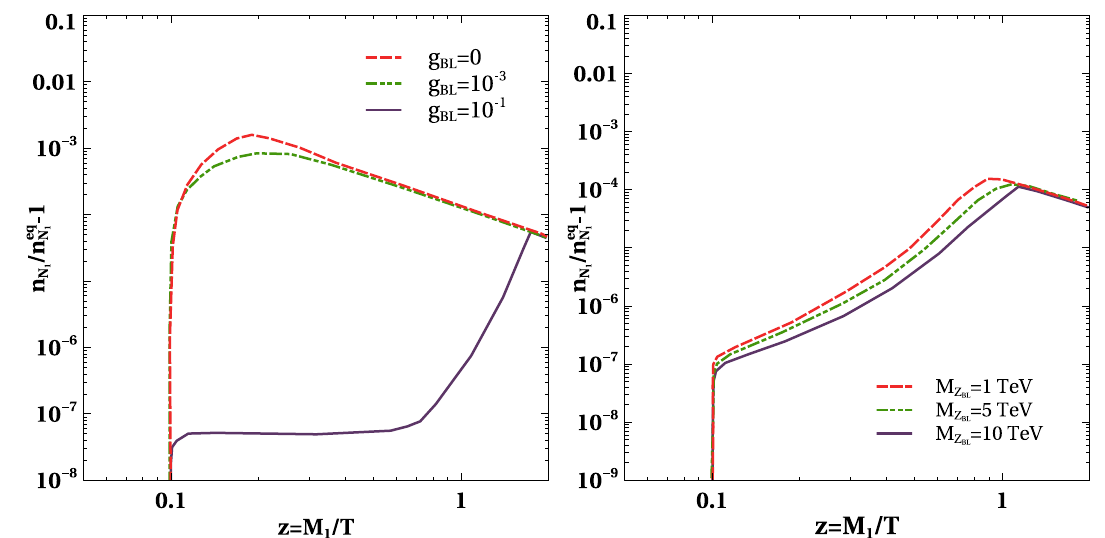
Fig. 10 The deviation of the comoving number density of N 1 (right plings relevant for leptogenesis are taken to be ( Y η ) α 1 = 10 − 5 ( 1 + i ) M 1 and ( Y η ) α 2 = 10 − 1 ( 1 . 1 − i ) . The other important parameters used are panel) with z = from its equilibrium density for different g BL M 1 = 15 TeV, M 2 = 150 TeV, m η = 5 TeV. For left (right) panel T (left panel) and for different M Z (right panel). The Yukawa cou- BL